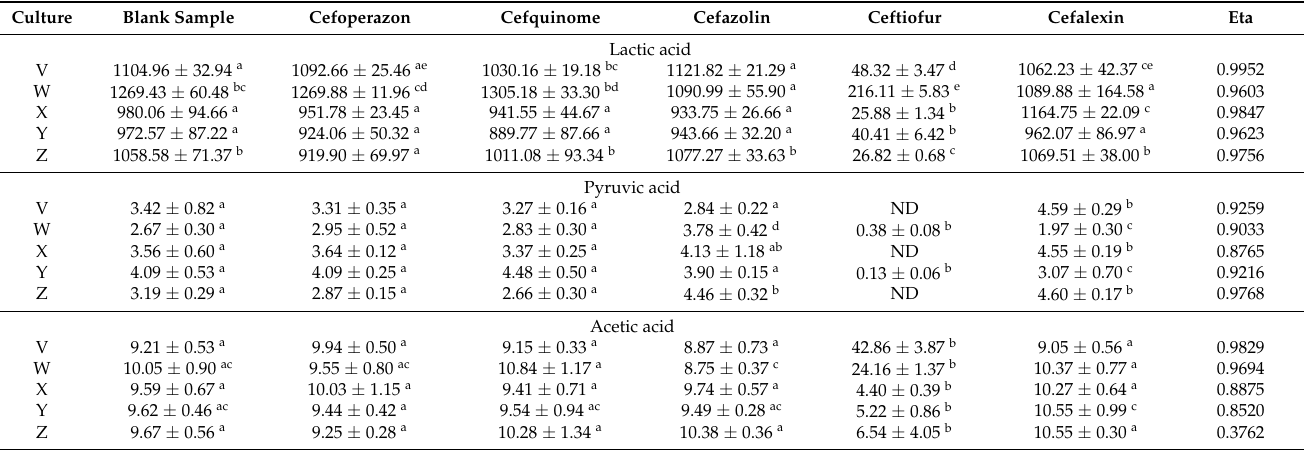
Table 3. Concentration of organic acids at the end of fermentation in samples fortified with cepha- losporins and in blank samples (mg 100 g −1 ).